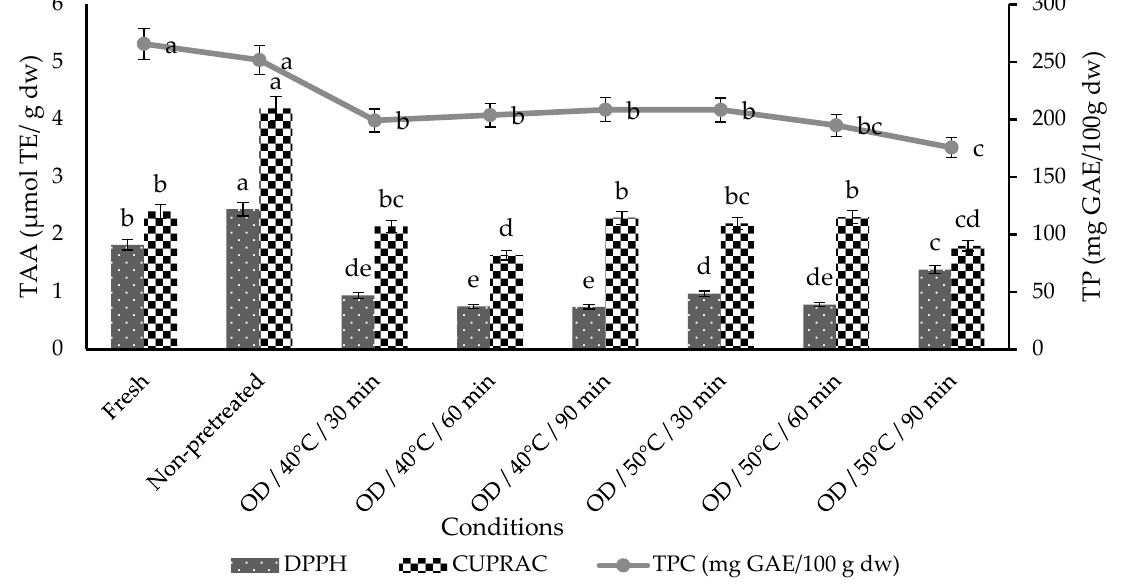
Figure 3. The effect of drying treatments on kumquats’ TAA and TPC. Different lower letters in bars and lines display significant differences ( p < 0.05), GAE: gallic acid equivalent, TE: trolox equivalent, dw: dry weight.